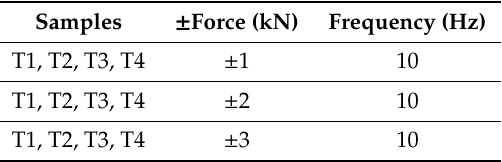
Table 11. Applied forces for fatigue